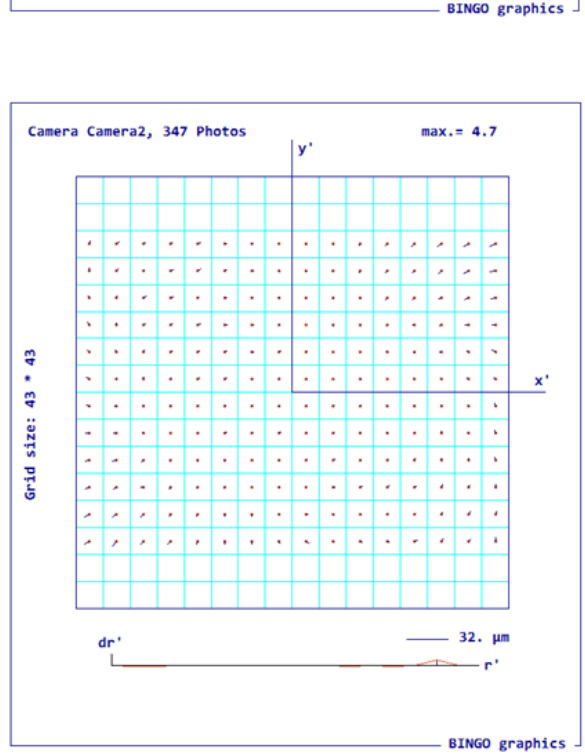
Figure 4. Remaining radial systematic effects before/after